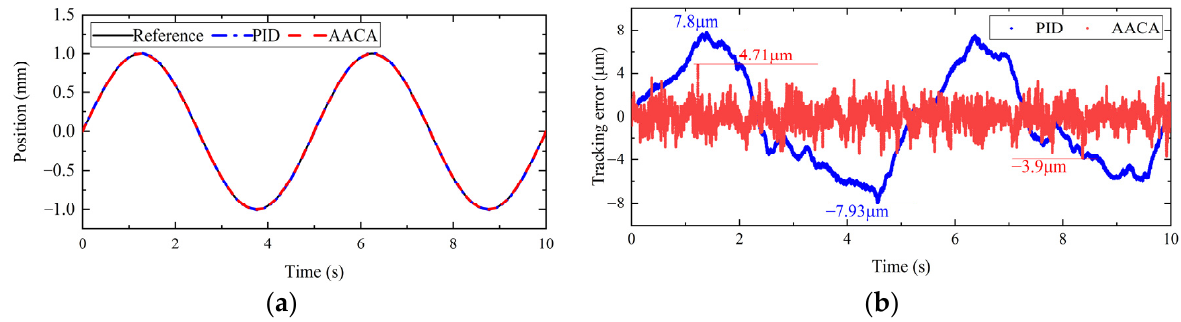
Figure 13. Experimental results of position and tracking errors before and after friction compensation